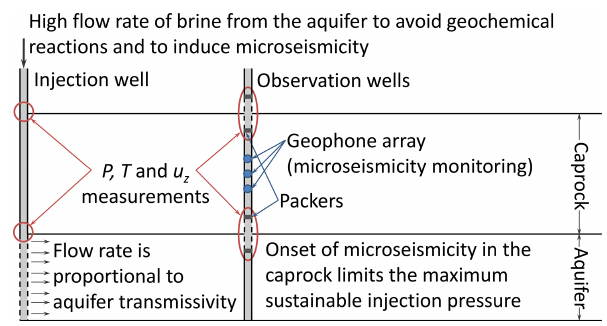
Figure 8. Hydro-mechanical characterization test proposed by Vi- larrasa et al. (2013b) to quantify the rock properties at the field scale and obtain an initial estimate of the maximum sustainable injection pressure. P refers to pressure, T to temperature and u z to vertical